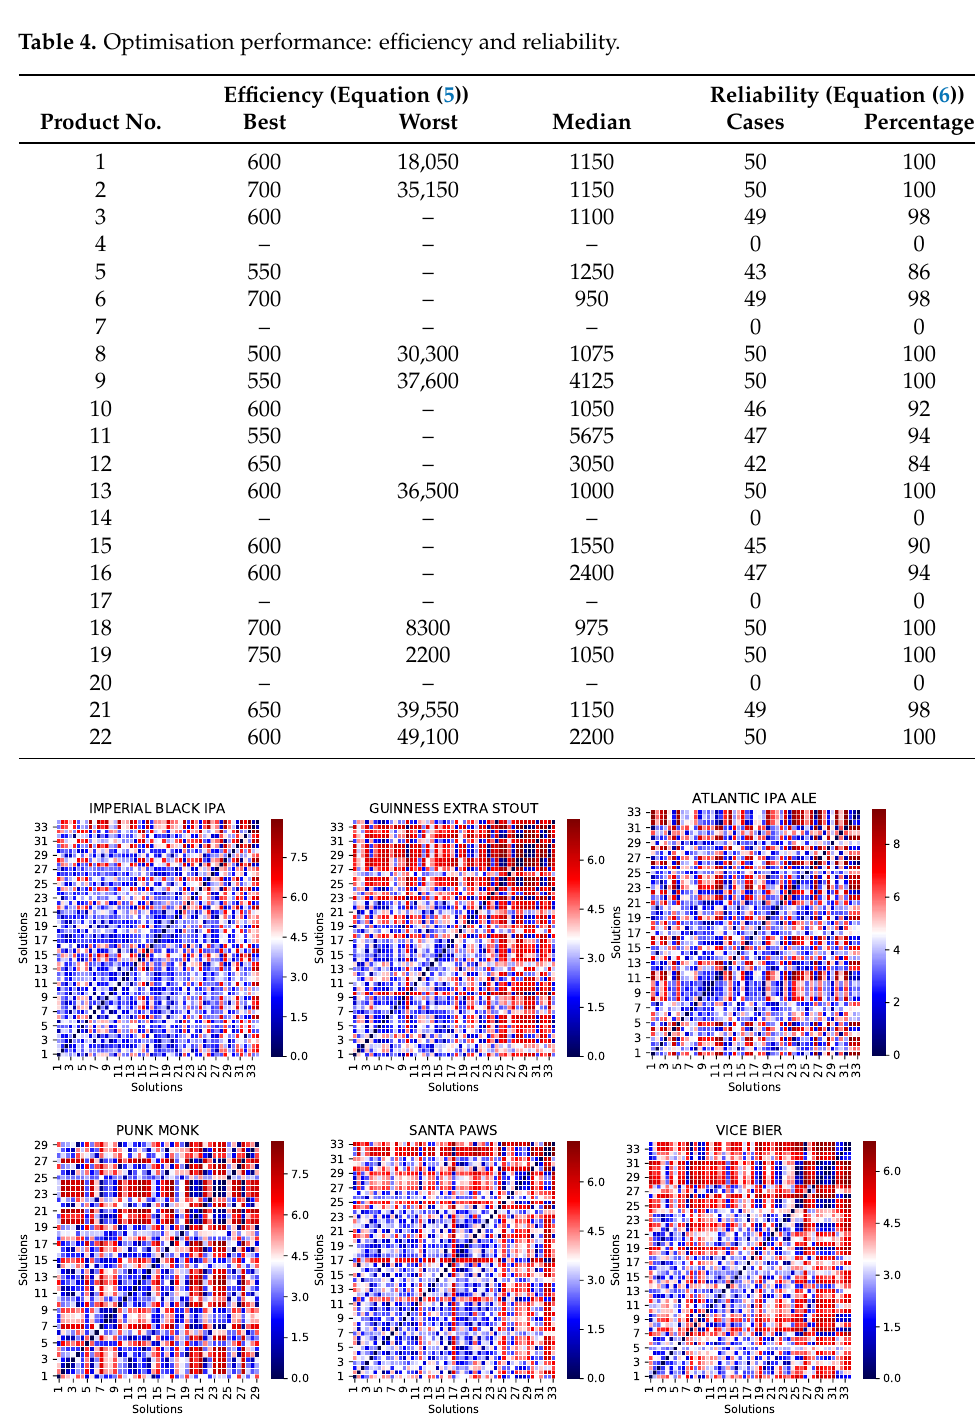
Figure 5. Solution vector distances. Visualising the distance matrices of the solution vectors in the first six optimised products (i.e., products 1, 2, 3, 5, 6, and 8). Note that, over the entire set of products, products 4, 7, and 14 have not been optimised. As for the rest of the products, only the valid solutions are considered (e.g., while Imperial Black IPA has 50 valid solutions, Punk Monk has 43). Table 5 presents the numerical summary of solution distance matrices, and the complete set of matrices is provided in Appendix A.2 in Figure